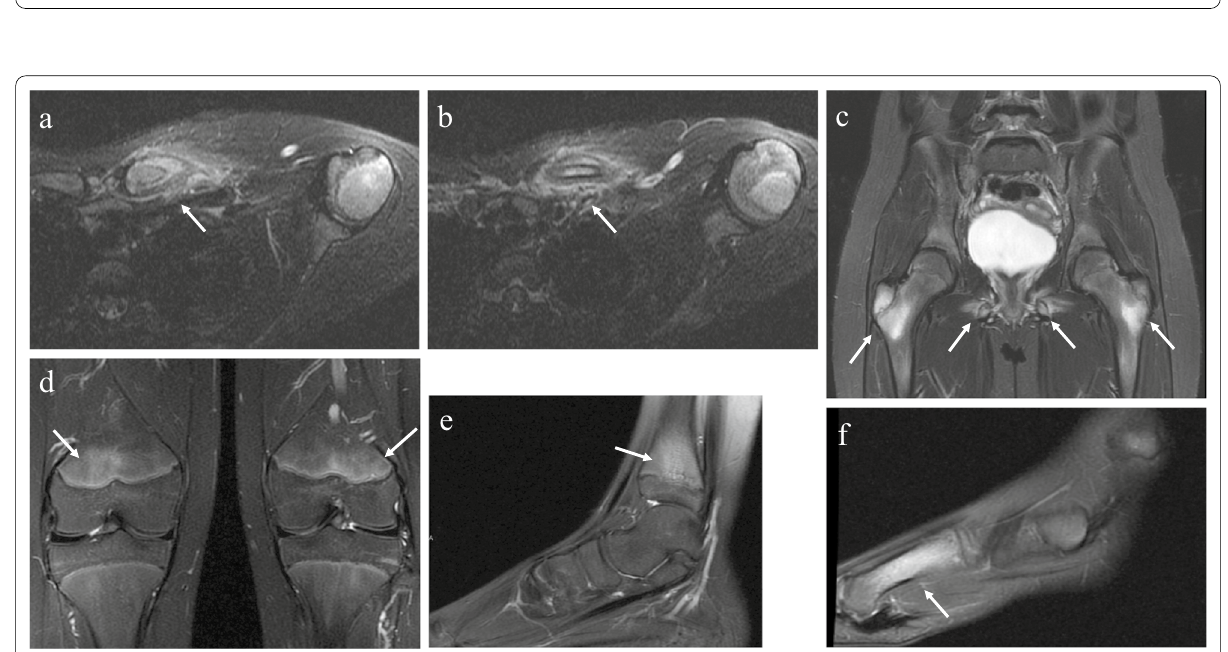
Fig. 7 An 11-year-old girl with a 3-month history of pain of the left clavicle. The laboratory findings showed slight increases in serum inflammatory markers (ESR 61 mm) and a normal blood count. Axial FST2wI images revealed bone marrow edema of medial third of the clavicle with periosteal = reaction and soft tissue edema ( a and b ). A study of the hip ( c ), knees ( d ) and ankle ( e ) showed periphyseal bone marrow edema and diaphyseal edema of the first metatarsal of the left foot ( f